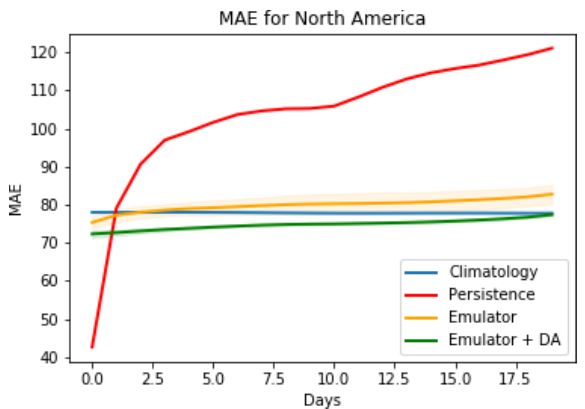
Figure 5. Geopotential height forecast MAEs for 20d for continen- tal North America, relative to the true test data. Results describe performance of a regular ML emulator and the same emulator cor- rected by variational data assimilation. Here we also show the re- sults of persistence, which is outperformed in the long-term predic- tion regime as